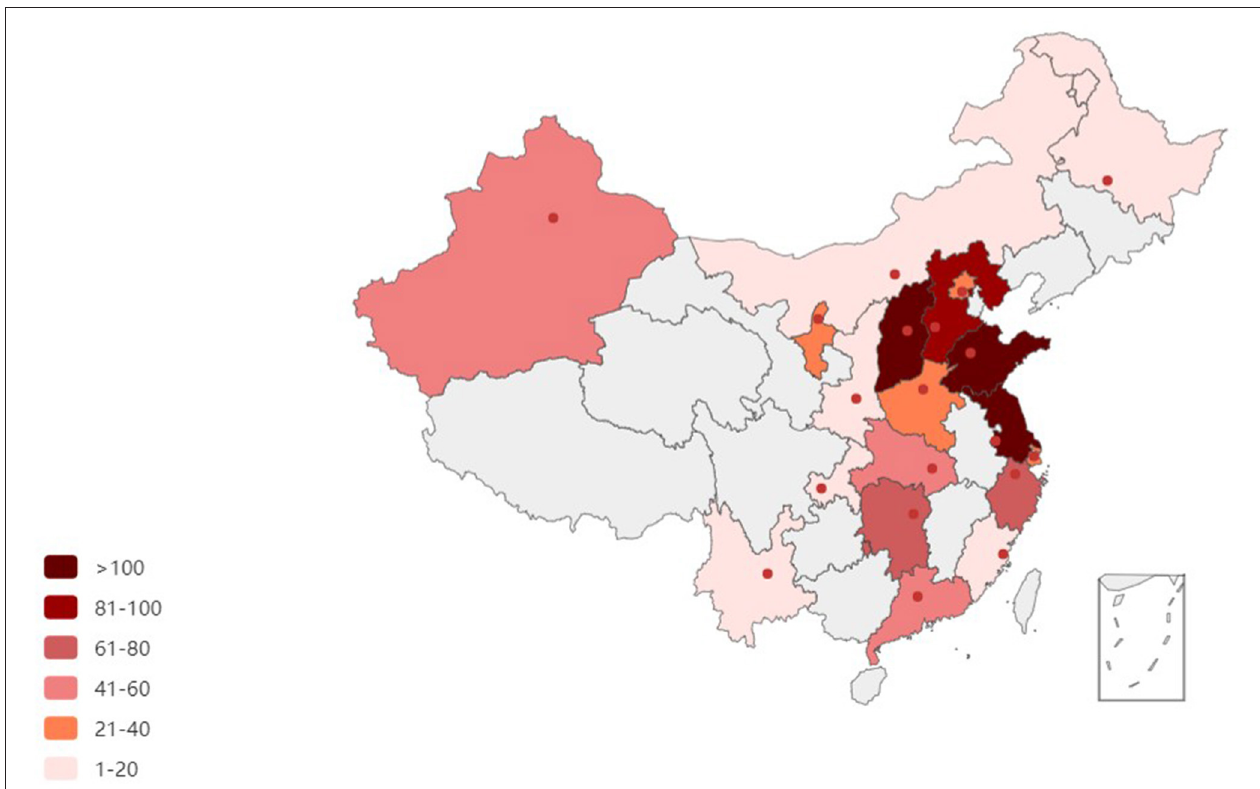
FIGURE 2 | Nationwide map of case